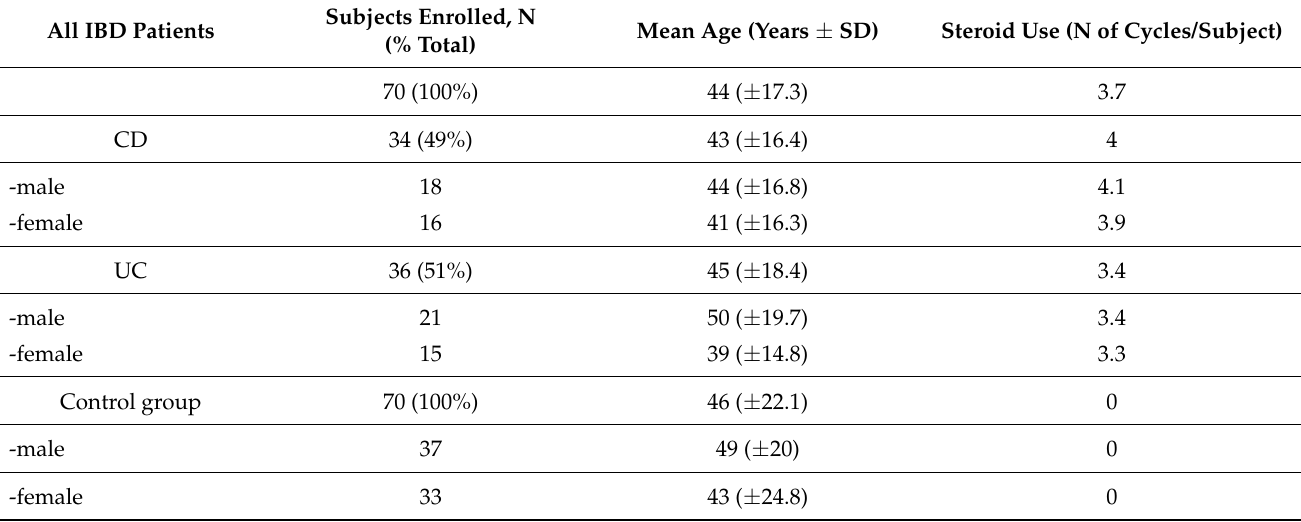
Table 1. Baseline characteristics of IBD patients and